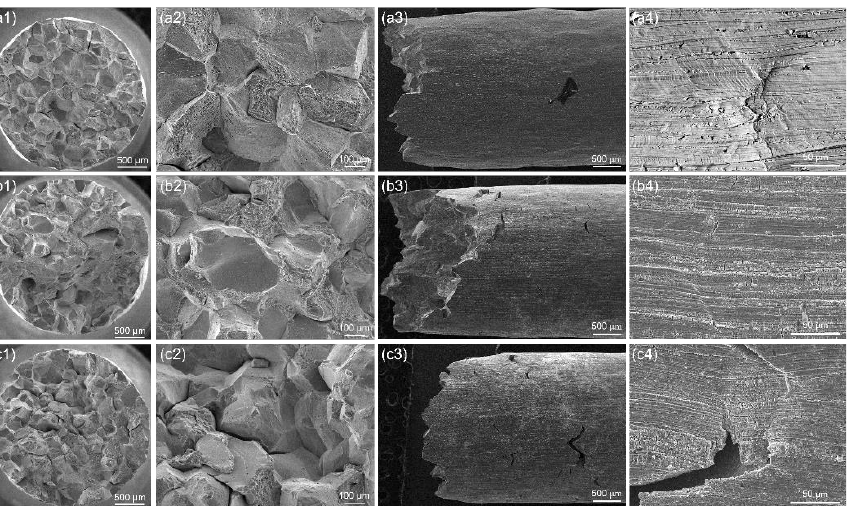
Figure 3. SEM images of the fracture surface after tensile tests of the Ni-Fe-based alloys at ( a ) room temperature, ( b ) 700 ◦ C, and ( c ) 750 ◦ C: ( a1 , b1 , c1 ) low magnification of cross-section surfaces, ( a2 , b2 , c2 ) corresponding high magnification of local region in ( a1 , b1 , c1 ), ( a3 , b3 , c3 ) low magnification of lateral surfaces, ( a4 , b4 , c4 ) corresponding high magnification of local region in ( a3 , b3 , c3